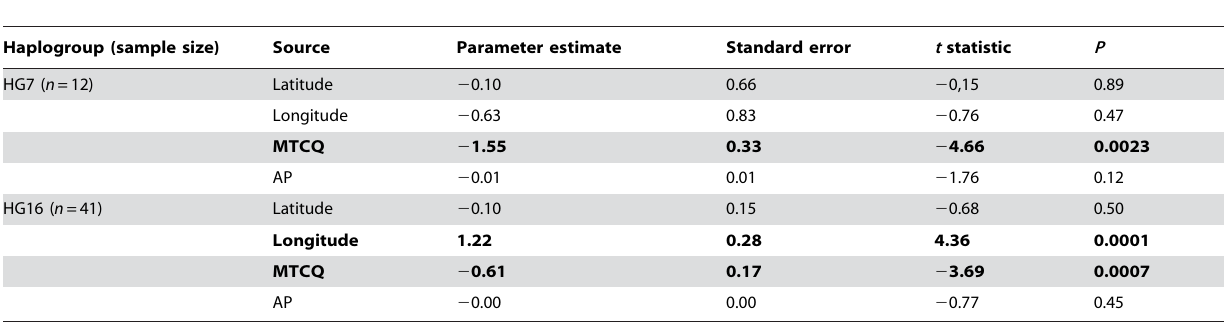
Table 4. Multiple regression analysis of the effects of latitude, longitude, mean temperature of coldest quarter (MTCQ), and annual precipitation (AP) on flowering time in Asian HG7 and